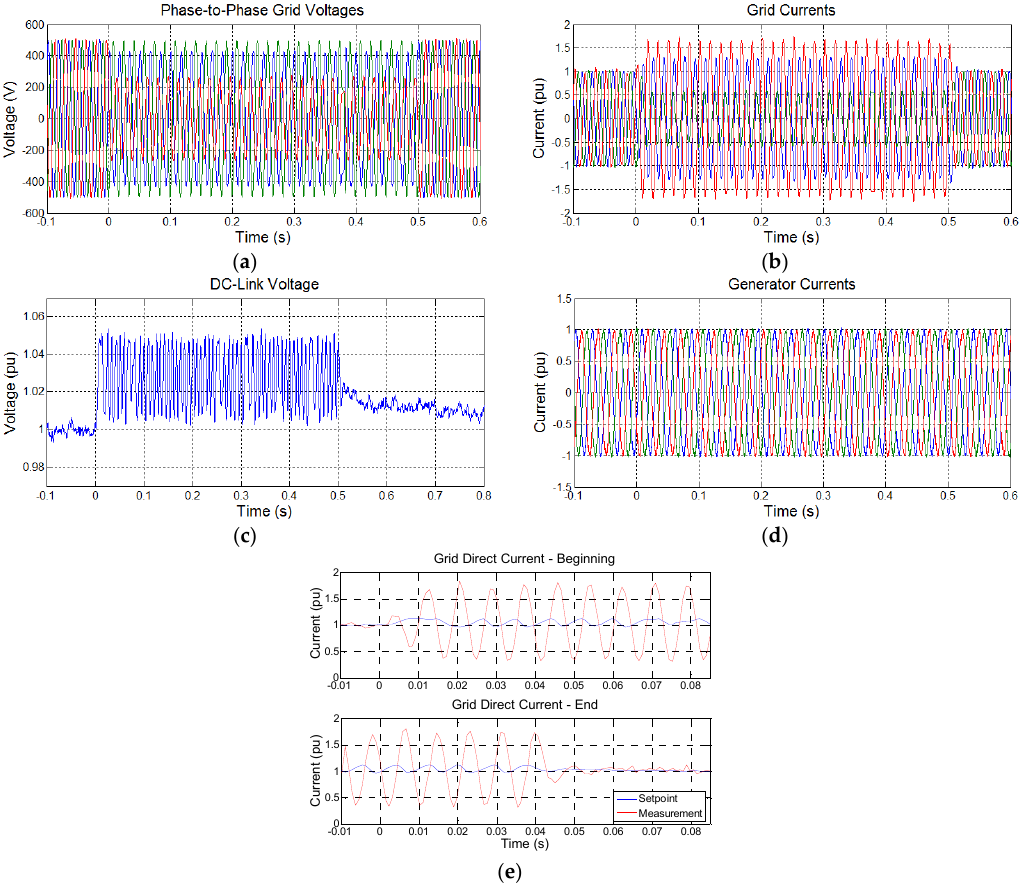
Figure 11. Experimental results for 50% phase ‐ to ‐ phase voltage sag with the system operating at 100% of rated power: ( a ) grid voltage; ( b ) grid currents; ( c ) DC ‐ link voltage; ( d ) generator currents; and ( e ) direct grid current (sag beginning and recovery instants).